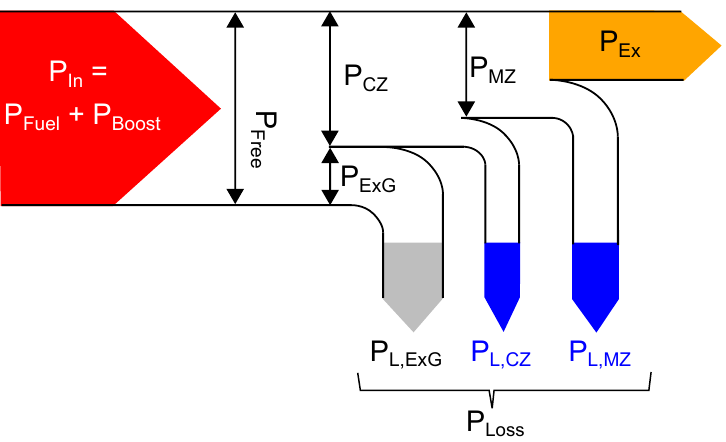
Figure 5. Efficiencies of fuel-fired and electric furnaces as a function of pull rate, adapted from Ref. [10]. In this work, a melting tank efficiency η MT of 42% is assumed for a 100 t/d oxyfuel melting system (see Section